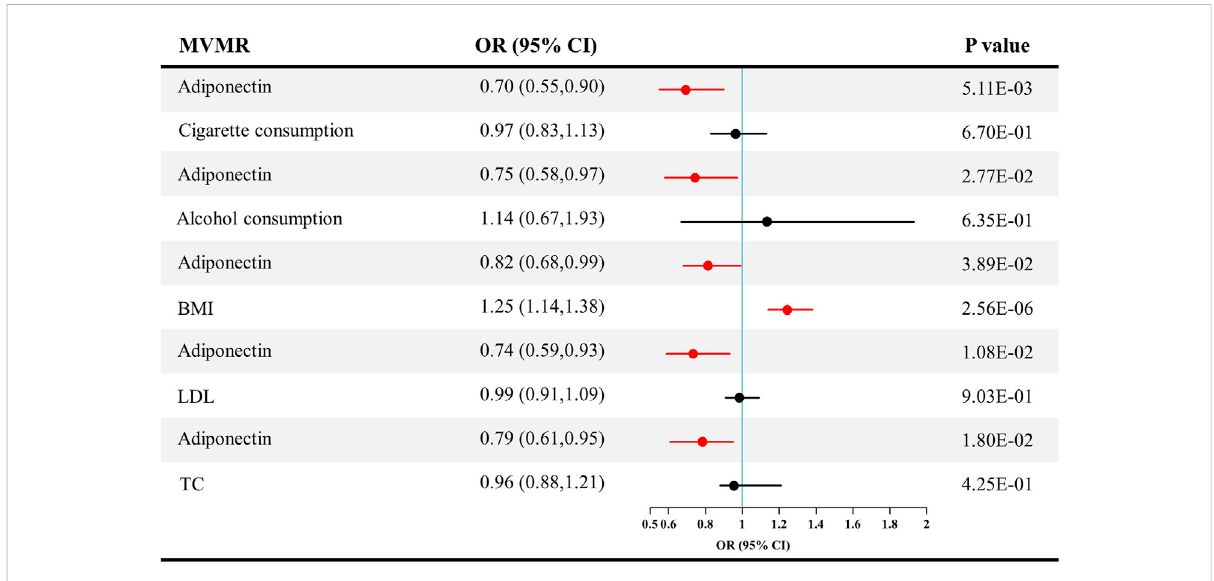
FIGURE 6 Causal estimates of adiponectin on CKD in multivariable MR. Red line, signi fi cant; Black line, not signi fi cant; OR, odds ratio; CI, con fi dence interval; LDL, low-density lipoprotein; TC, total cholesterol; CKD, chronic kidney disease; MVMR, multivariable Mendelian